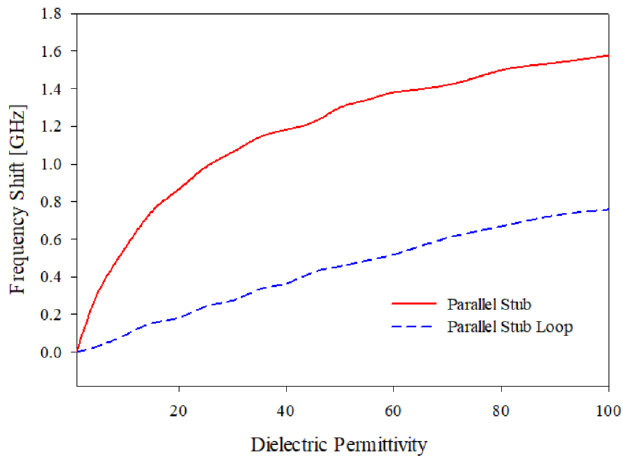
Figure 21. Sensing applications, T-shaped stubs and T-shaped stub of length equal to L parallel to the feeding line. Frequency shift versus dielectric permittivity of liquid substances placed on the resonator top